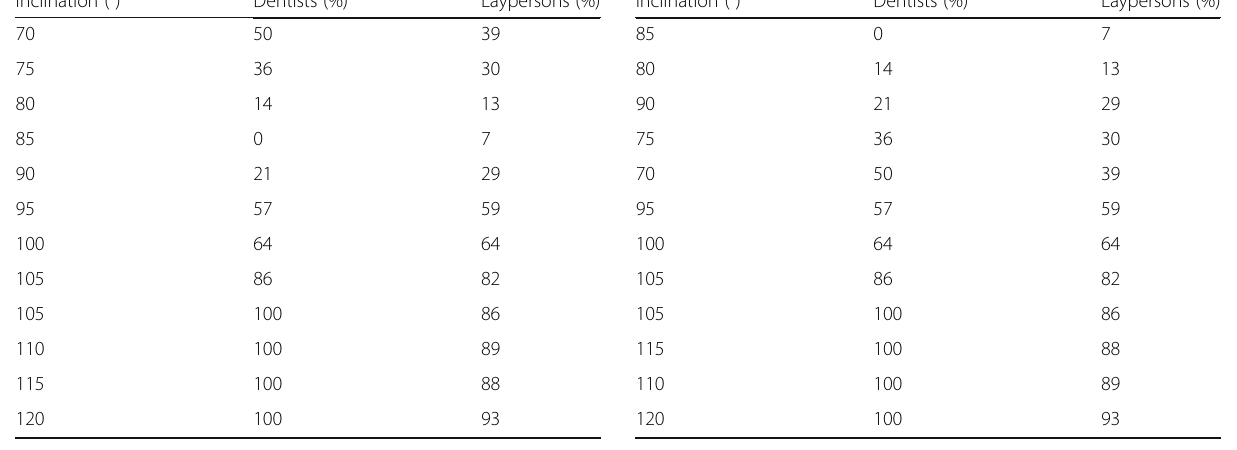
Table 4 Proportion of clinicians and laypeople suggesting a desire for treatment for images (ordered by proportion) Inclination (°) Dentists